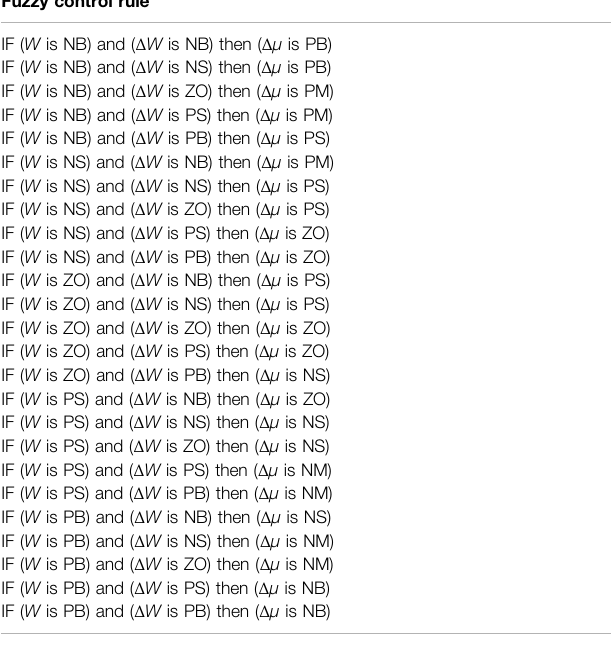
TABLE 1 | Fuzzy control rule table.